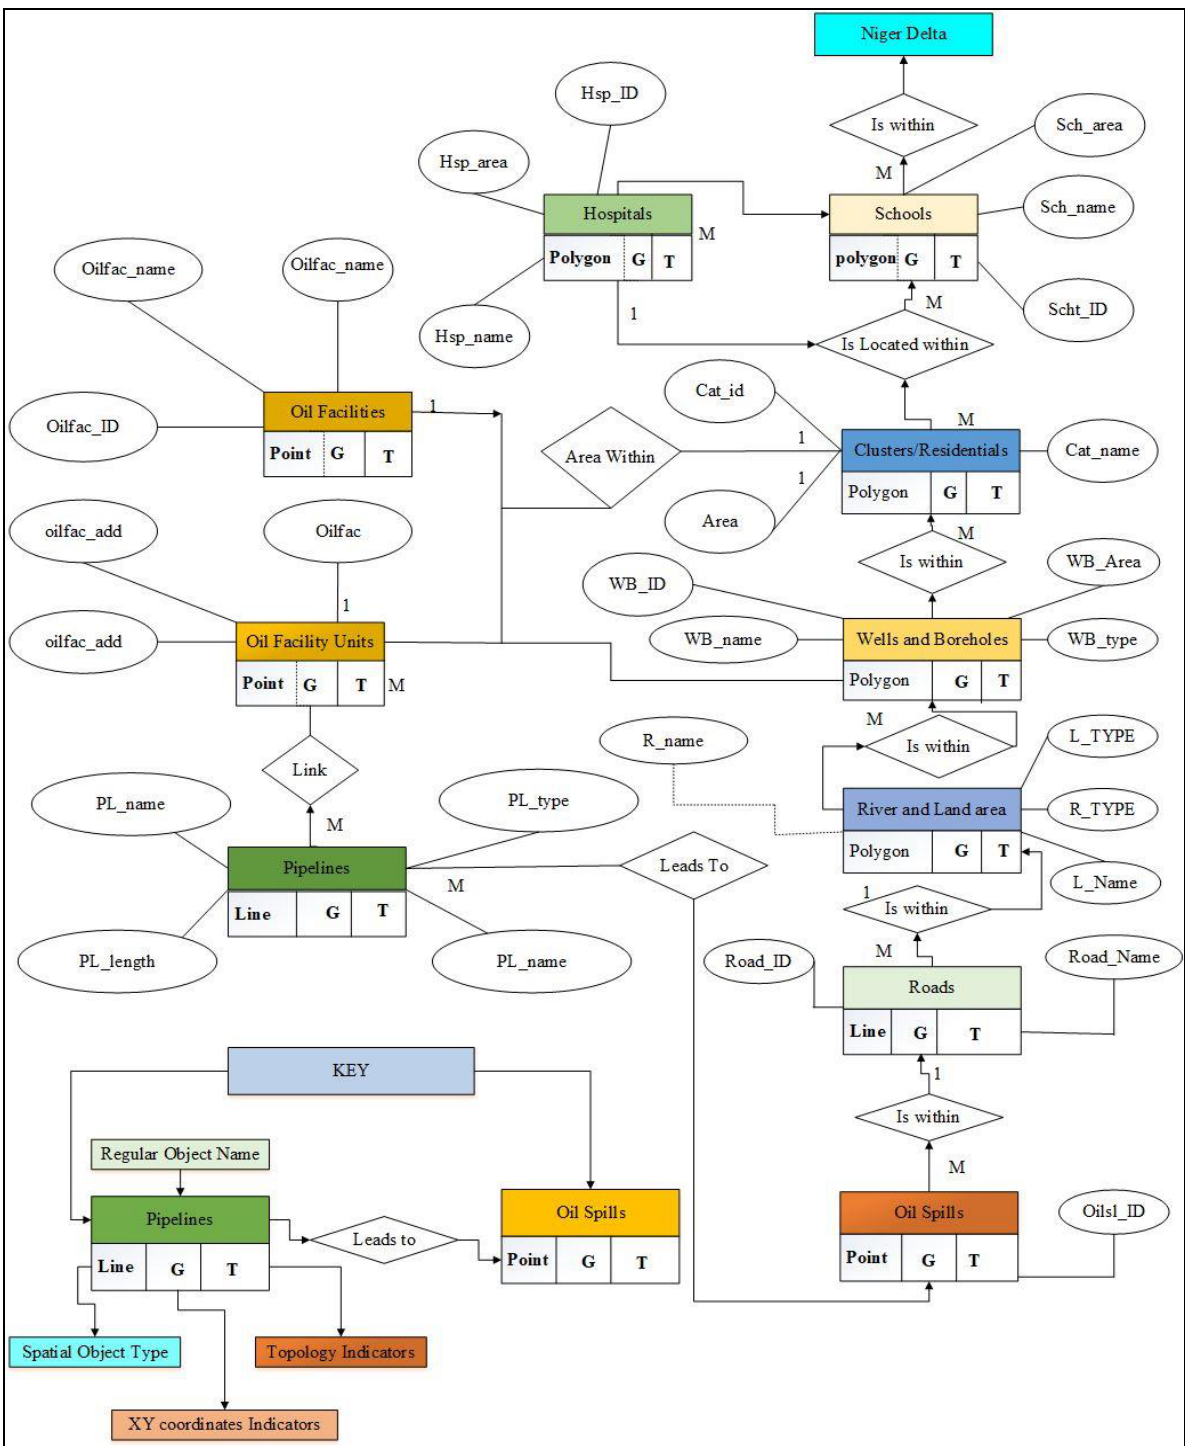
Figure 7. ER Diagram of the